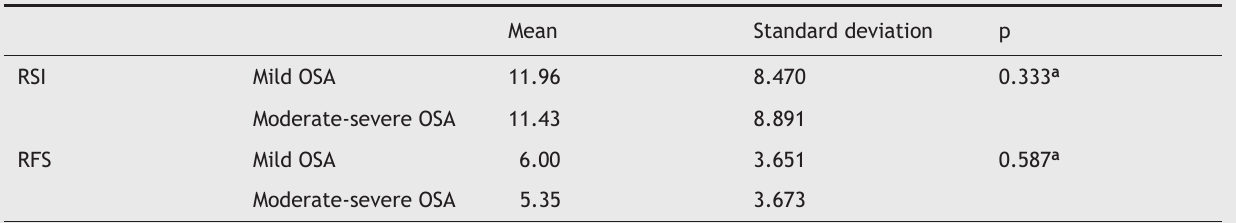
Table 2 t -test for equality of means in non-obese patients.